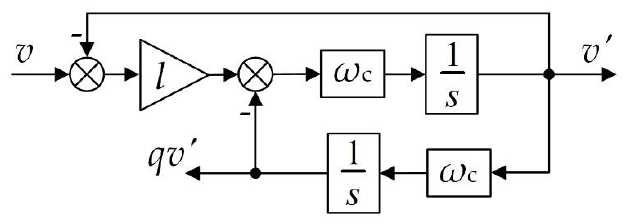
Figure 7. Bode diagram of SOGI.